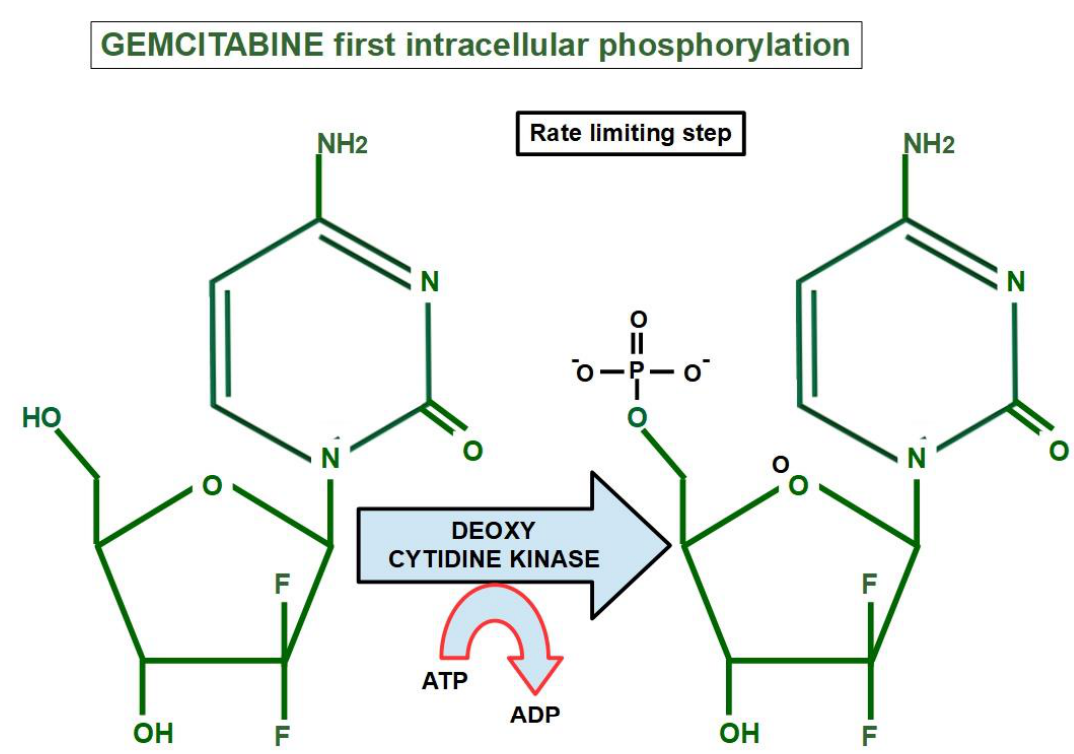
Figure 4. Gemcitabine’s first intracellular phosphorylation by deoxycytidine kinase. Acquired downregulation of deoxycytidine kinase impedes the first step of gem- citabine’s activation , thus resulting in resistance [241]. Low expression of deoxycytidin kinase entailed a poor prognosis and shorter survival in patients with resectable pancre- atic cancers receiving chemotherapy [242].